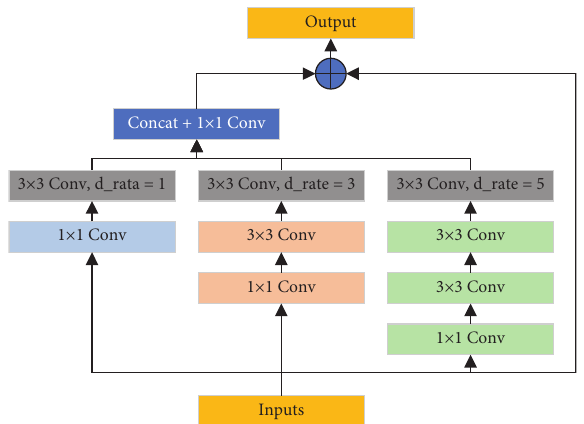
Figure 5: Structure of the multiscale receptive field layer.